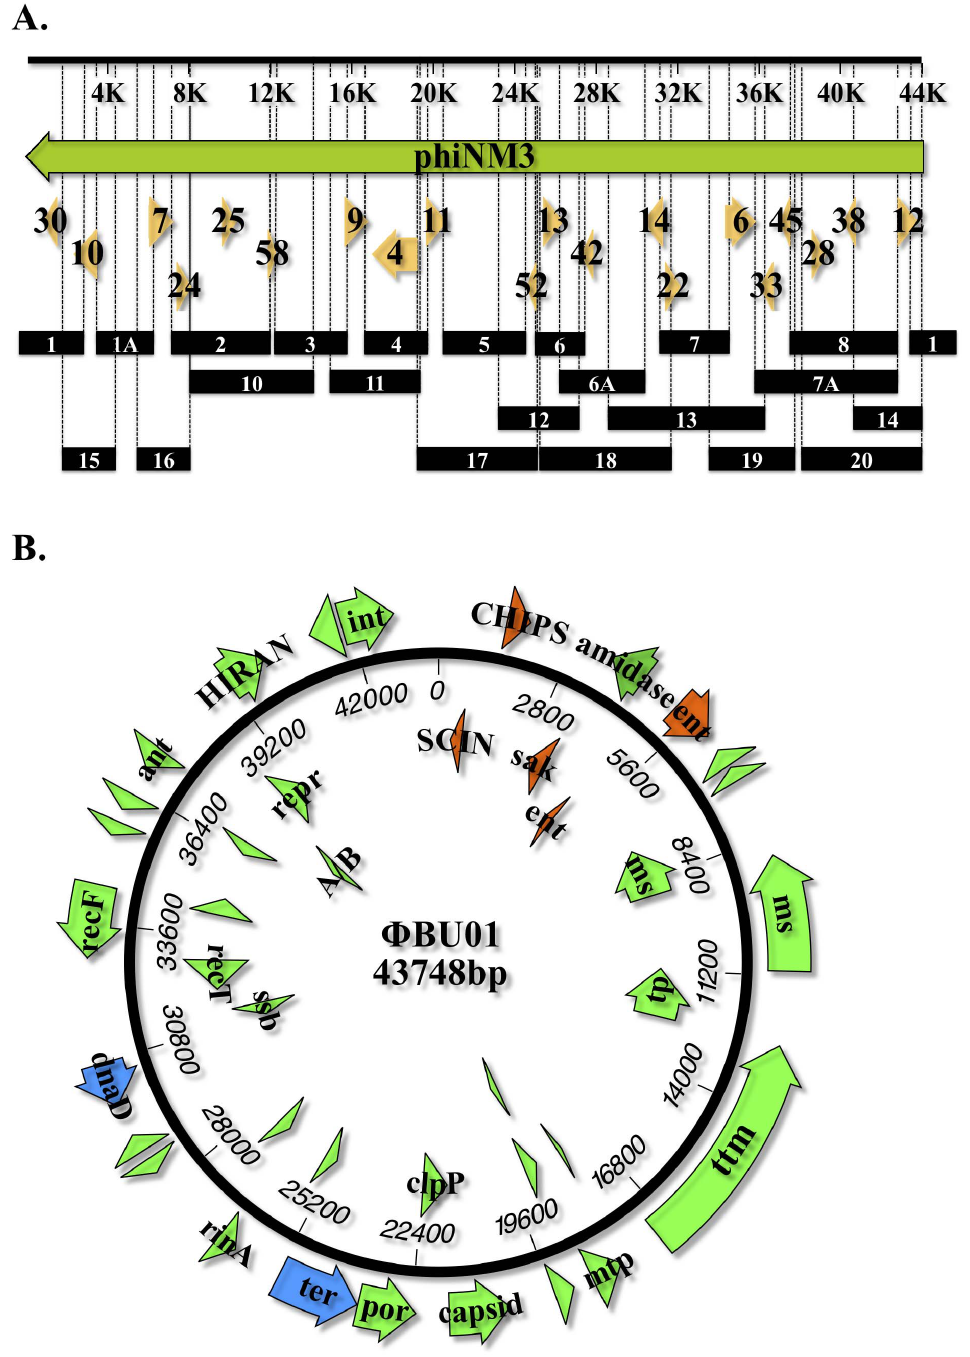
Figure 3. Strategy for genome sequencing of Q BU01 from VISA strain NRS19 and completion of a genetic map resulting in a single circular contig. (A) Initial 454 sequencing of an unknown ExP F in VISA strain NRS19 was assembled relative to S. aureus bacteriophage F NM3 (NC_008617.1) template sequence. Alignment was generated using an algorithm with default settings in MacVector Version 12.6 [30,31]. The preliminary alignments of 454 sequencing contigs (orange arrows, Table S3 in File S1, File S2) were used as a reference to generate PCR amplifications (black bars) to be used for primer walking and to determine unknown sequences. Numbers inside orange arrows designate specific contig numbers. Primers used to generate the ExP F sequences (numbers within black bars designate PCR product) through primer walking (Sanger) are listed in Table S2 in File S1. (B) Physical map of VISA W BU01. Genes in orange indicate toxins encoded on the prophage, blue indicates genes associated with DNA replication and processing, and green indicates structural, miscellaneous, and hypothetical (blank arrows) genes. A list of the genes and descriptions are in Table S6 in File S1.